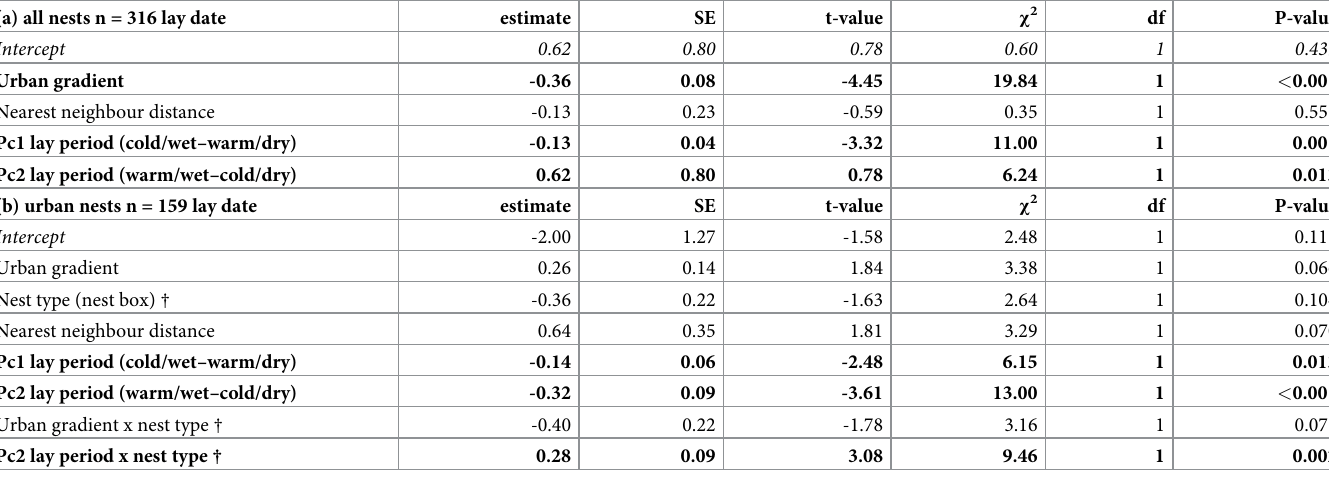
Table 3. Linear mixed effects model for the timing of breeding (lay date) for successful nests only in relation to (a) the urban gradient (1–78% urban cover); and (b) nest type (nest boxes versus other), nearest neighbour distance (log transformed) and weather conditions during the egg-laying period (spring). Estimated lay period of 52 and 24 peregrine territories, respectively, over 26 years (1989–2014) on the Cape Peninsula.